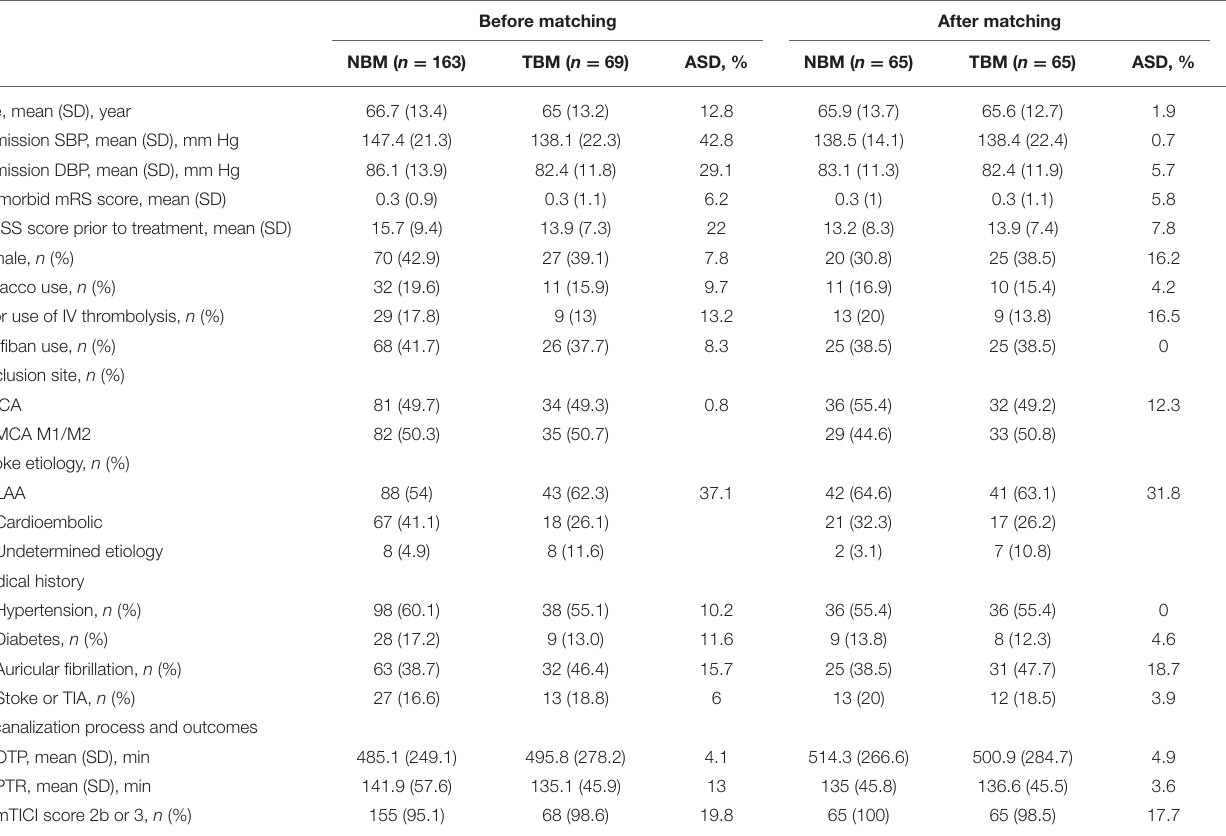
TABLE 1 | Baseline clinical and anatomic characteristics, endovascular procedures, and clinical outcomes of patients with ELVO according to blood flow monitoring approach before and after PSM. Before matching After